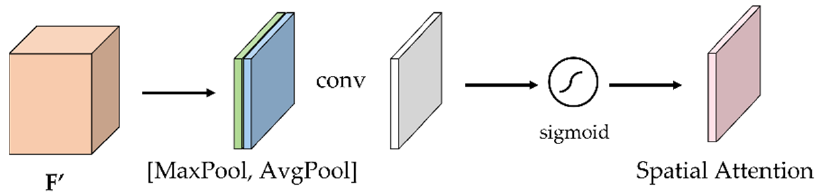
Figure 6. The structure of the Spatial Attention Module.